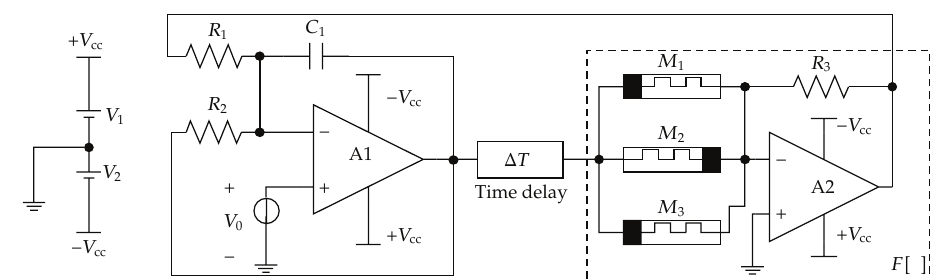
Figure 7: The circuitry implementation of memristive delayed system.